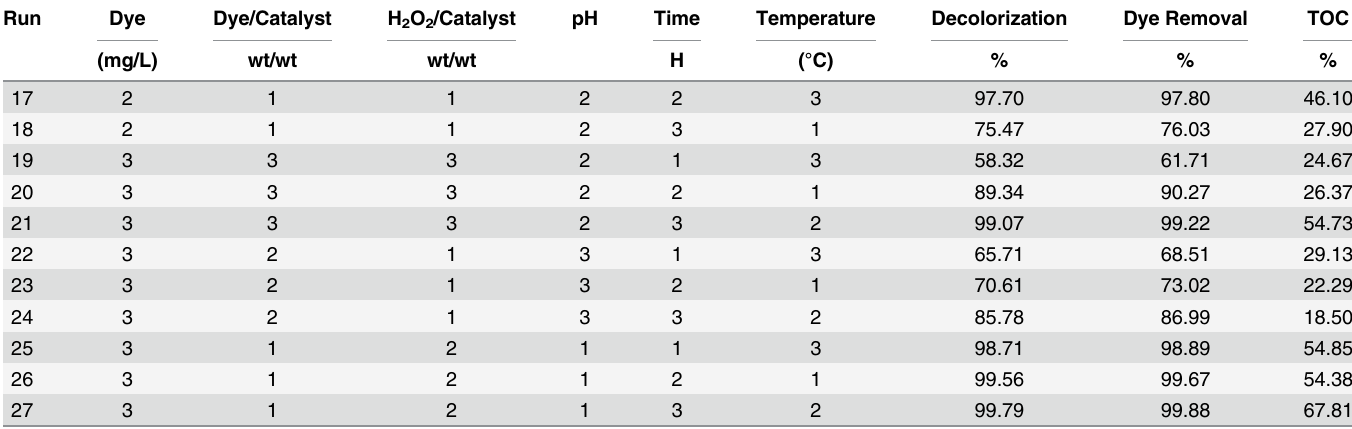
Table 5. L27 orthogonal design, experimental results, and Taguchi analysis for run 17 to